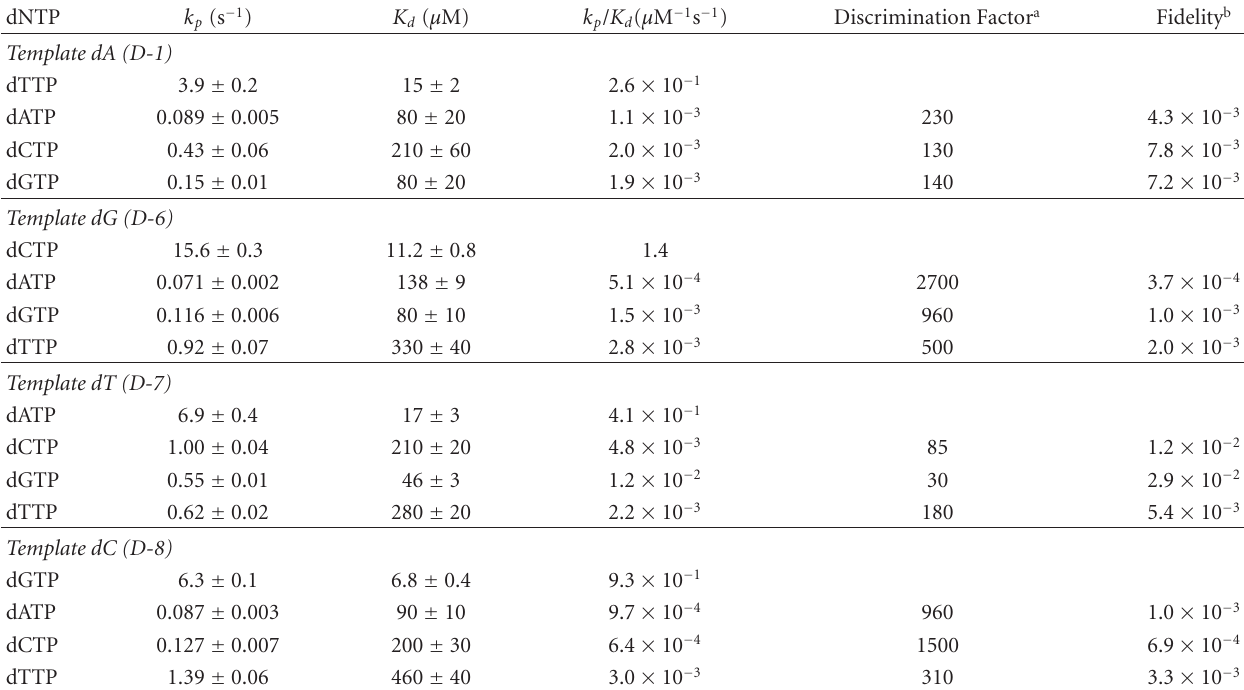
Table 3: Kinetic parameters of nucleotide incorporation into D-DNA catalyzed by truncated yPol η at 23 ◦